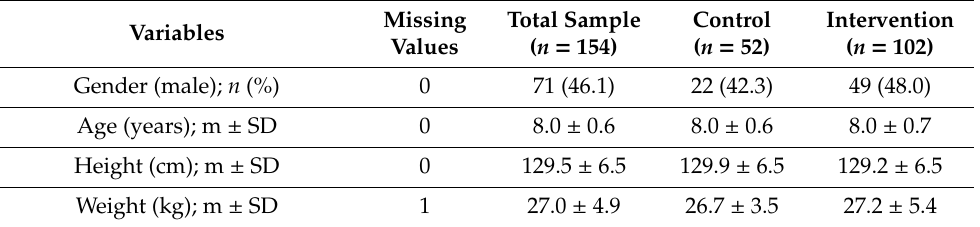
Table 1. Descriptive characteristics of total sample, control and intervention group at follow-up. Missing Variables